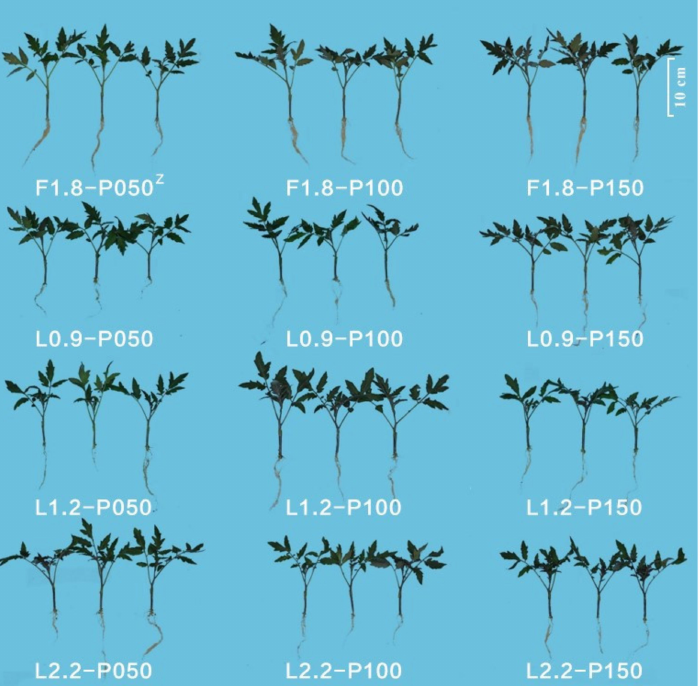
Figure 3. Effects of light quality during the whole seedling period and photon flux density in the healing stage on the morphology of grafted tomato transplants. Z Symbol represents lighting source of F1.8 and photon flux density of 50 µ mol m − 2 s − 1